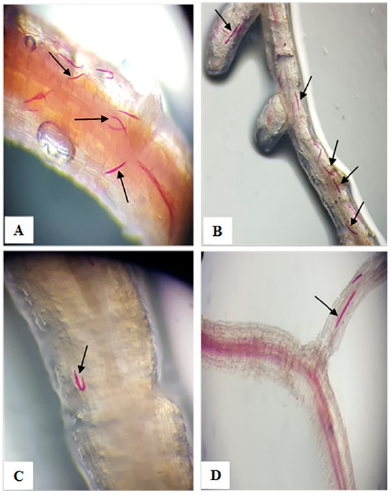
Figure 1. Comparison of the number of Meloidogyne javanica larvae in the highly susceptible cultivar Dutch Mobil ( A , B ) and the moderately resistant cultivar ALYSTE F-1 ( C , D ) in a part of the root. Arrows show nematode larvae in the roots. Acid-fuchsin was used to stain root-knot nematodes in the roots.